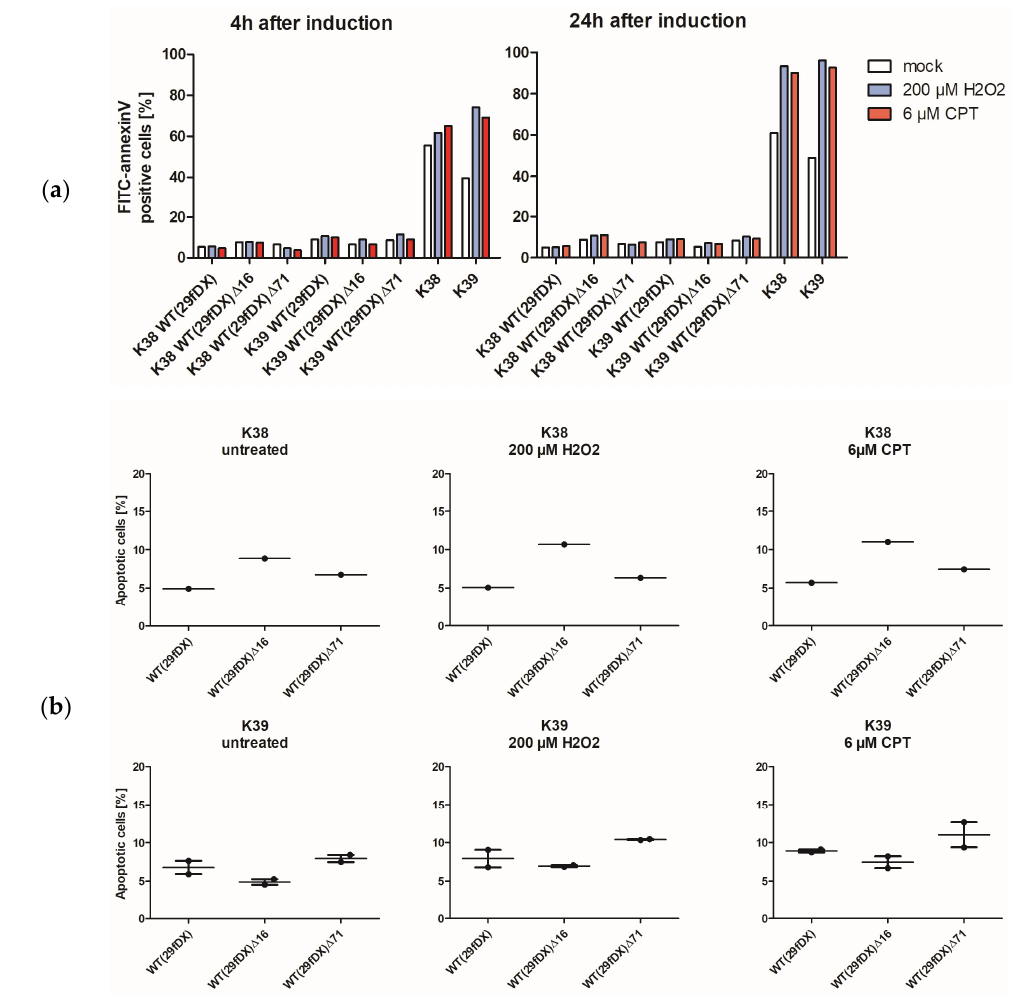
Figure 5. Scatter-plots of FITC-positive cells in percent indicating annexin V-presenting cells. ( a ) Percent of apoptotic cells in transformed cells of donors K38 and K39. Self-repaired wild-type virus WT(29fDX) or a deletion variant with either ORF16 or ORF71 deleted were initially used to transform the cells 31 months prior. Effects of apoptosis inducers hydrogen peroxide (H 2 O 2 ) or camptothecin at indicated final concentrations were investigated 4 h and 24 h post-induction. ( b ) Effects of the two inductors compared between cells of the same donor, transformed with the different self-repaired virus variants 24 h post-induction. Cell numbers did not suffice for more than one (K38 cell lines) and two experiments (K39 cell lines), respectively.